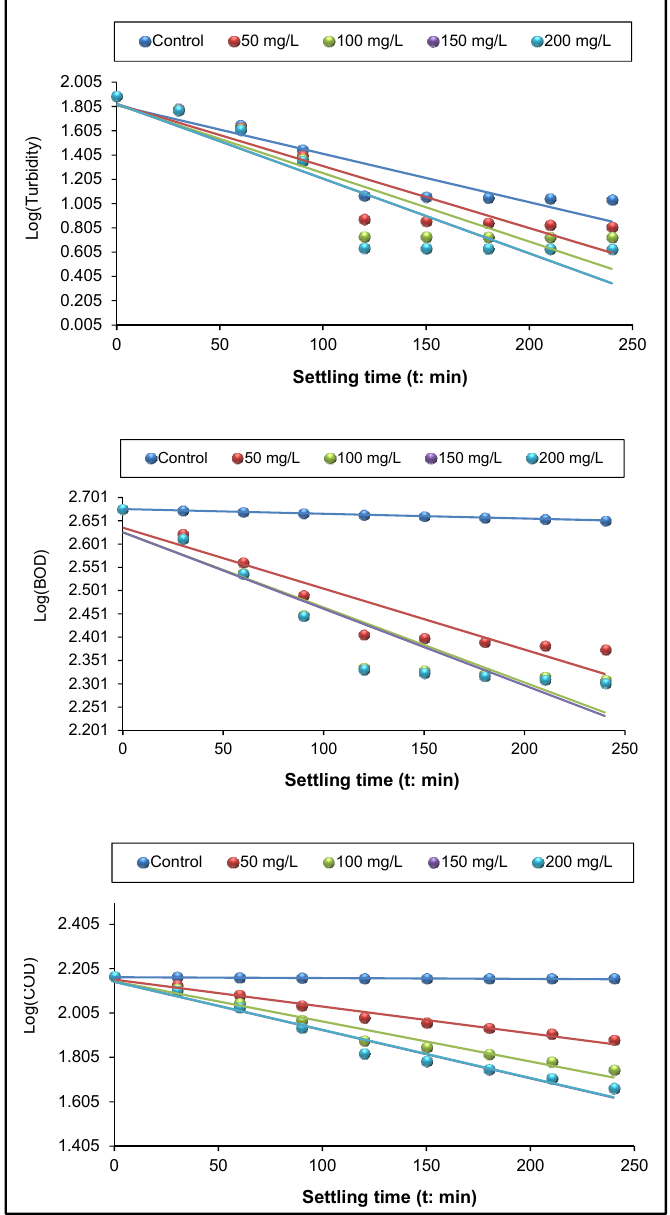
Figure 2. Log(C) versus time (t: min) plots of turbidity, BOD, COD removal of municipal wastewater.